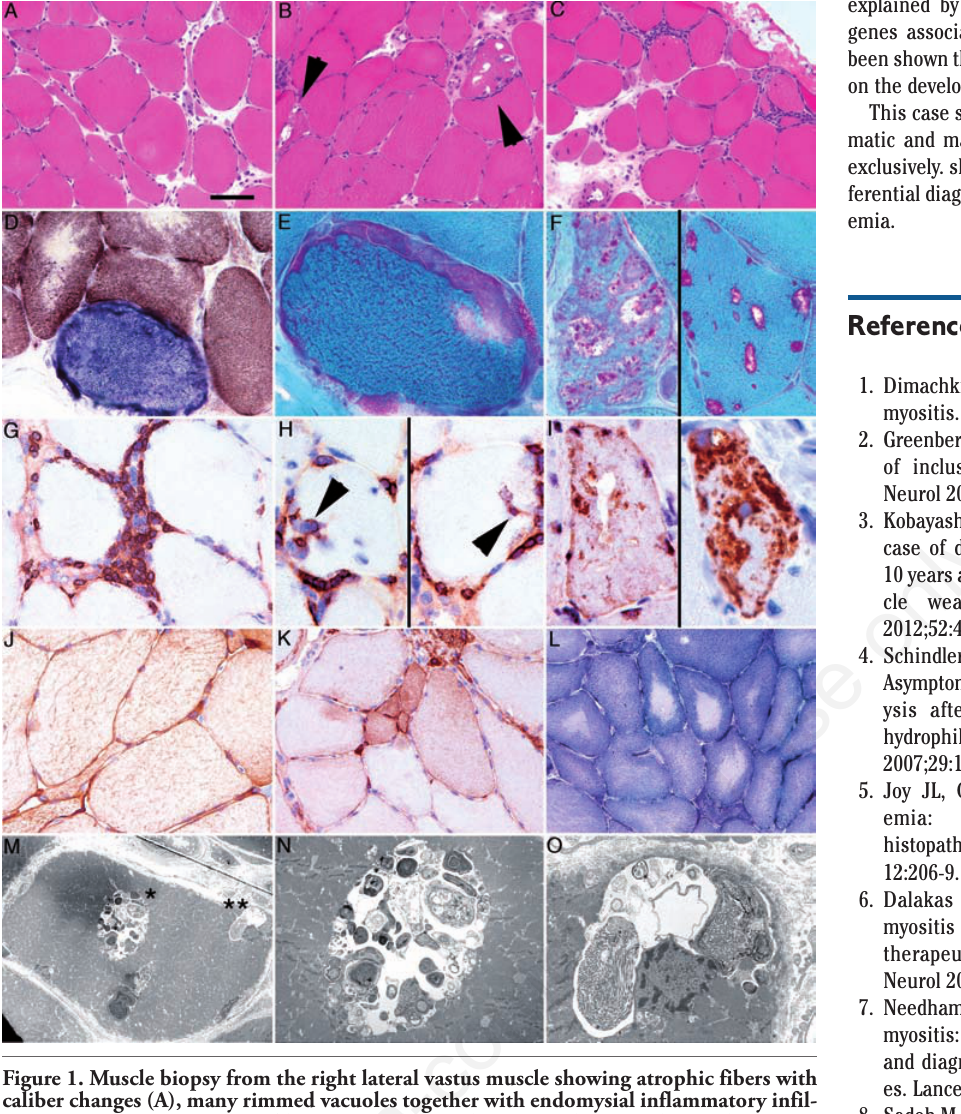
showing the typical features of invasion of non-necrotic fibers by mononuclear cells, vac- uolated muscle fibers, and either intracellular amyloid deposits or tubulofilaments 15-18 nm